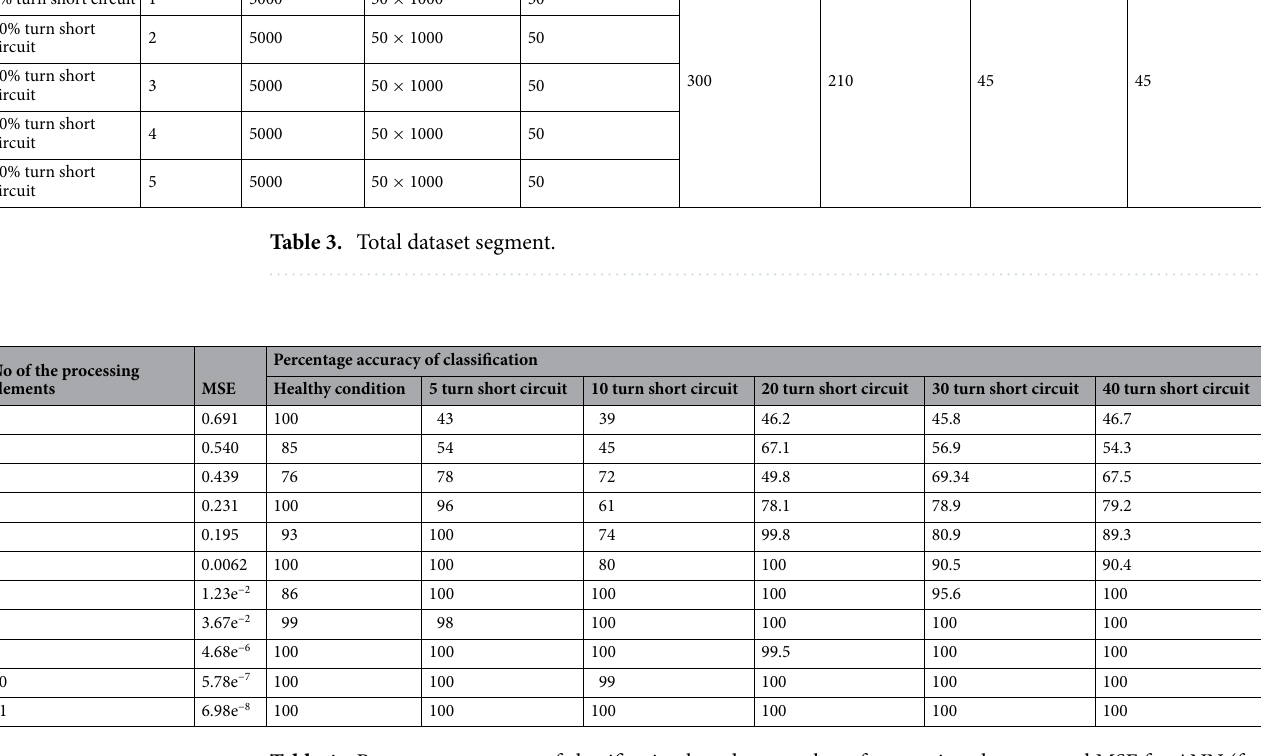
Table 4. Percentage accuracy of classification based on number of processing elements and MSE for ANN (for training